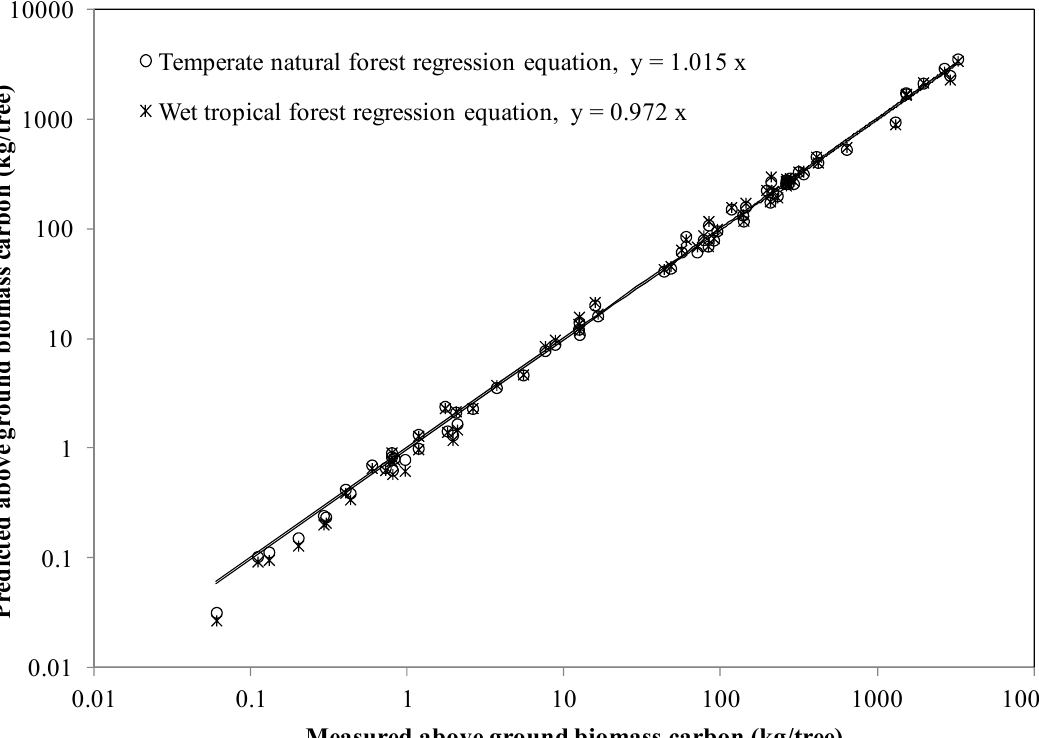
Measured above ground biomass carbon (kg/tree)